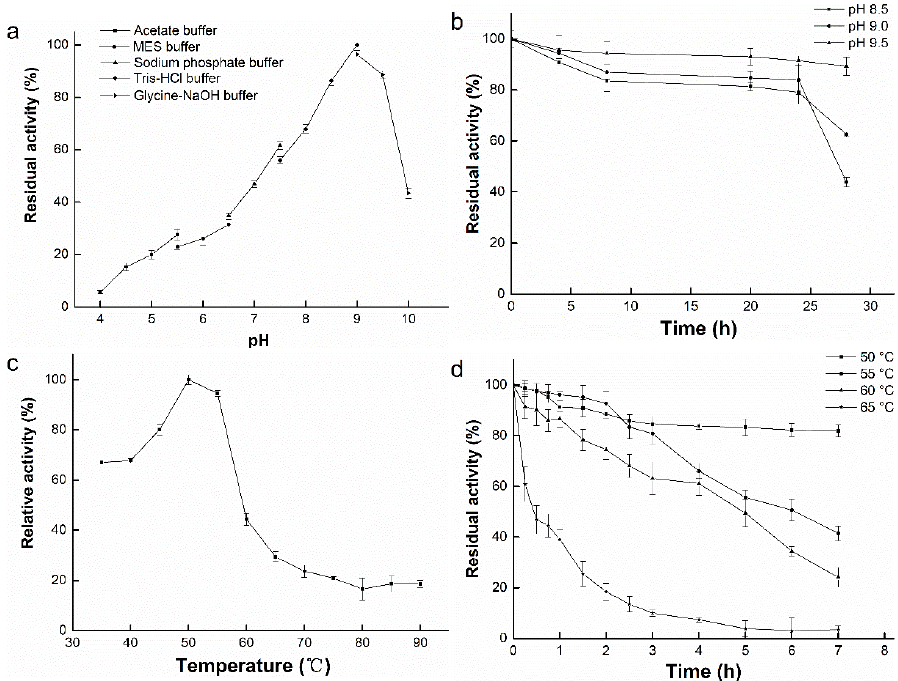
Figure 3. Properties of BpFAE. ( a ) Effect of pH. ( b ) Stability of pH. ( c ) Effect of temperature. ( d ) Thermal stability. The data were acquired in triplicate experiments.